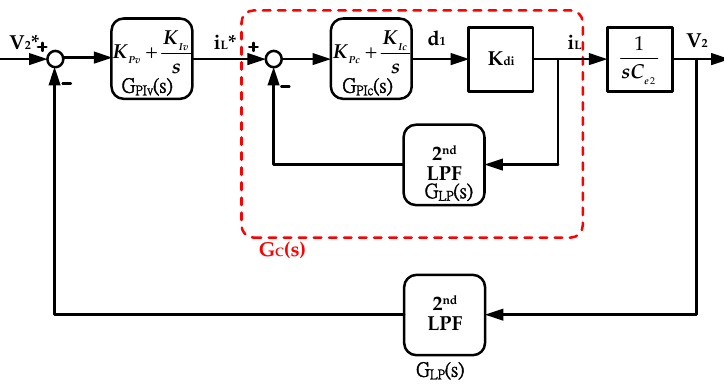
Figure 10. Schematic diagram of the dual-loop controller.